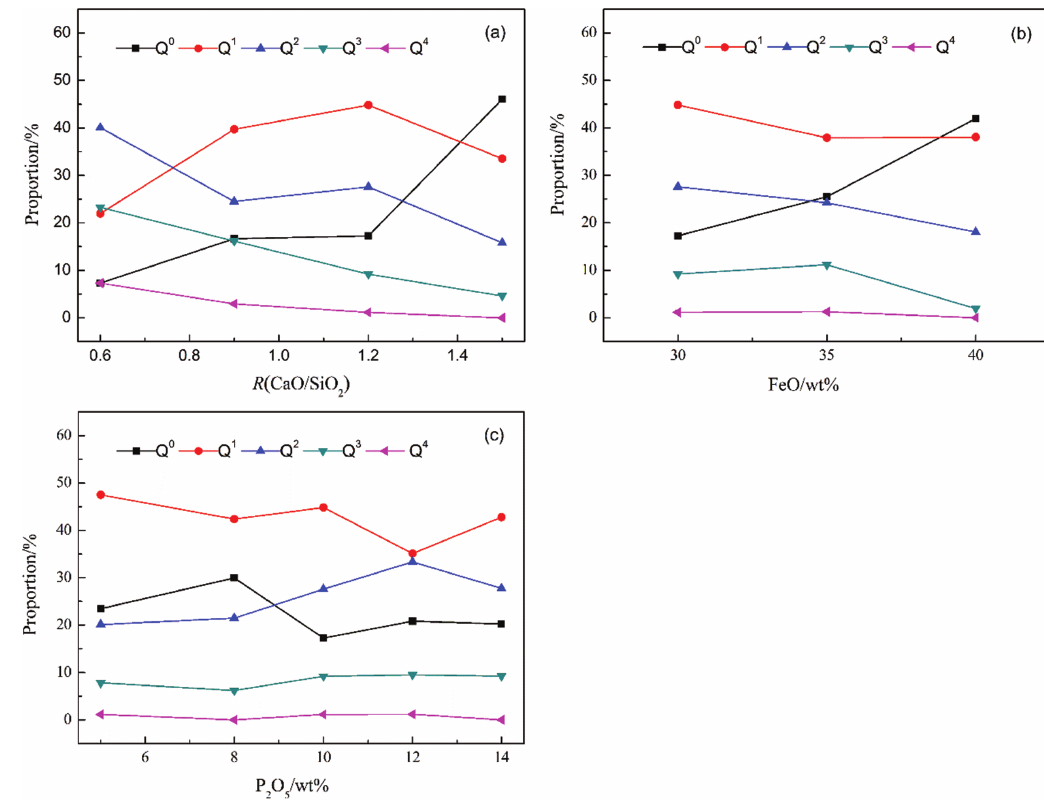
Figure 3: Effect of (a) basicity, (b) FeO content and (c) P 2 O 5 content on Q n (Si + P).